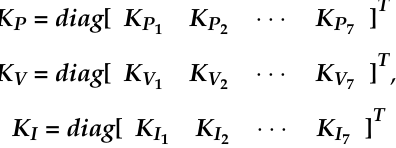
Figure 3. Schematic diagram of PID control.